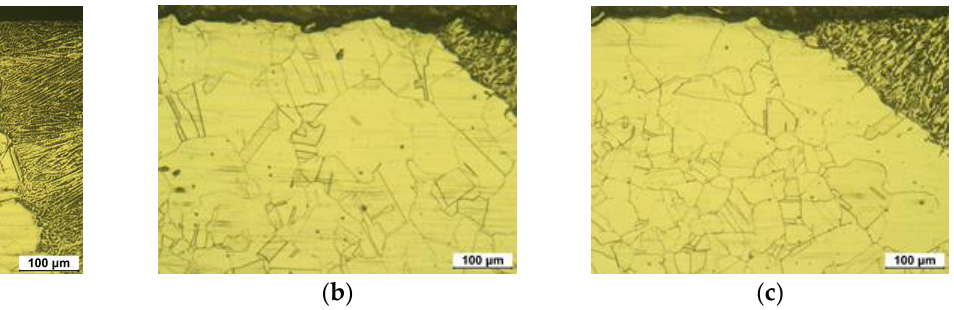
Figure 8. Optical microstructure of the cross-section of 304L HAZ area after LP (OM, ×200, 10% oxalic acid): ( a ) 304LB, ( b ) 304LB-L-NC, and ( c ) 304LB-L-WC. The outermost surface was flat and the grain size number was calculated as 7.527,